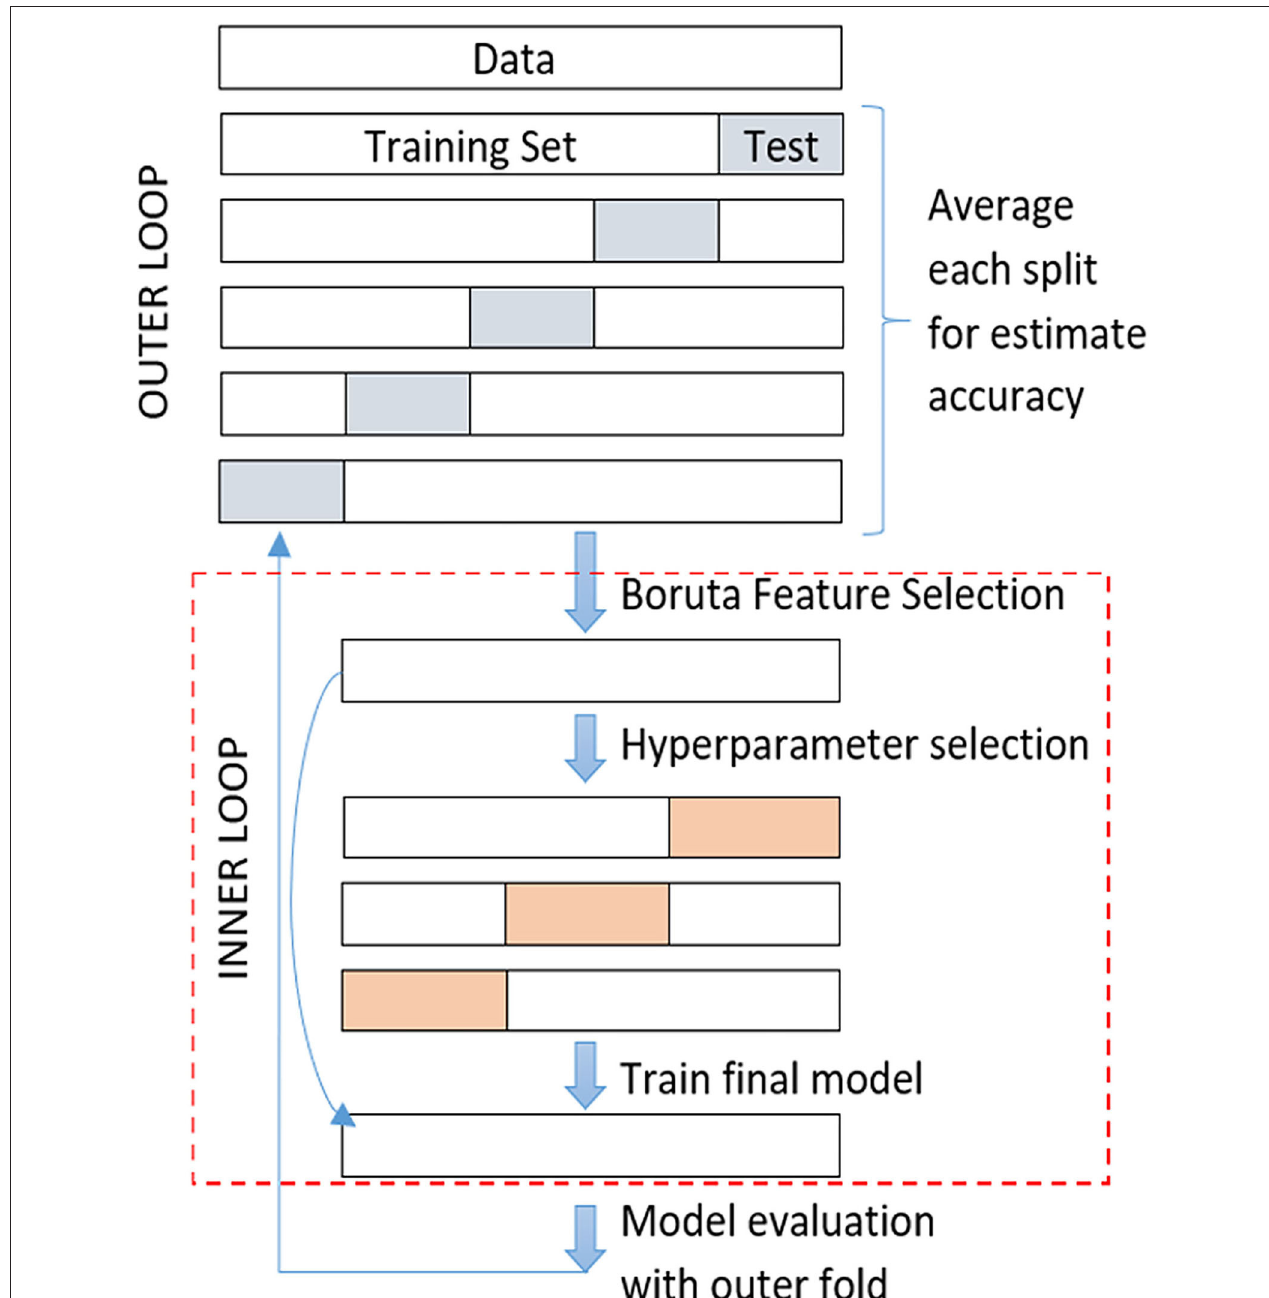
FIGURE 4 | Feature selection steps applying nested